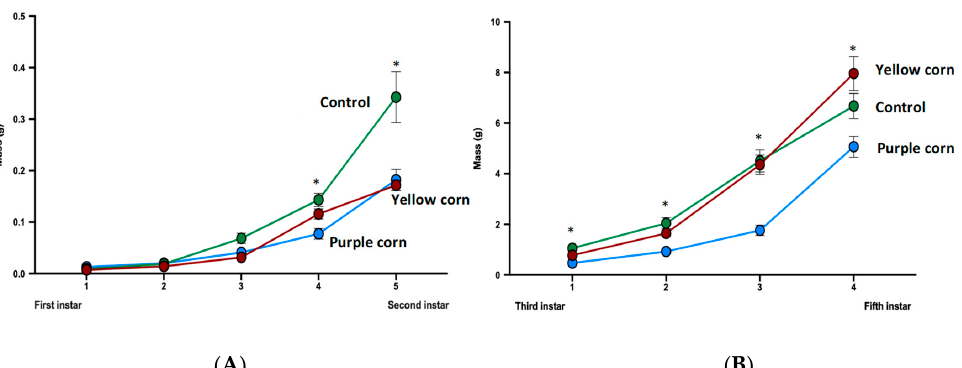
Figure 4. Mean first instar to second instar larval mass ( A ) and third instar to fifth instar larval mass